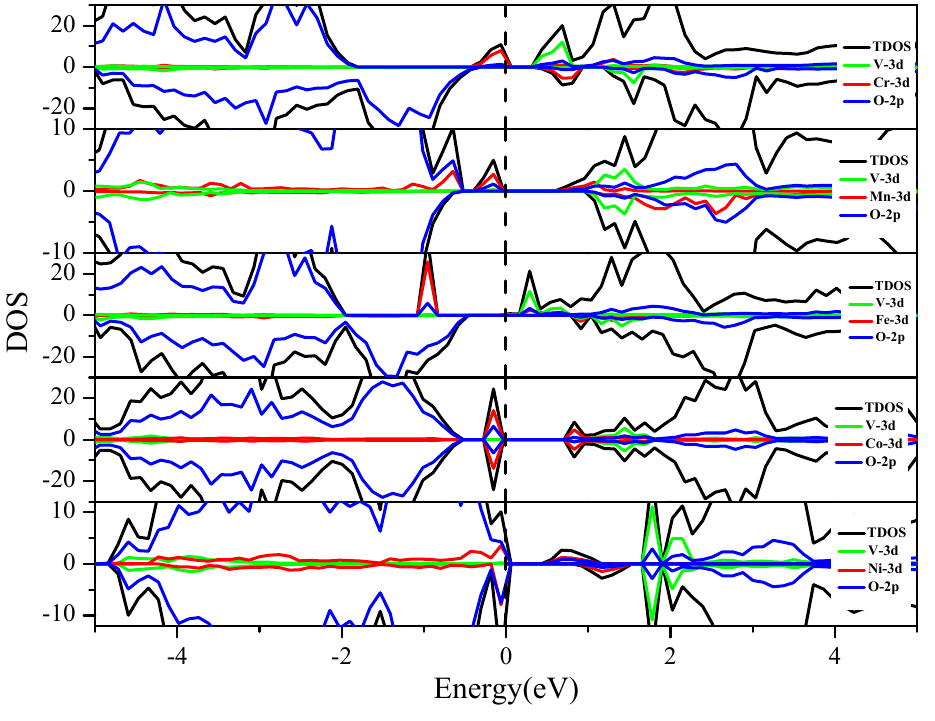
Figure 4. The total and partial density of states of the V-M ″ (3d metal elements: Cr, Mn, Fe, Co, and Ni) co-doped BaTiO 3 . The black dashed line indicates the position of the Fermi level.